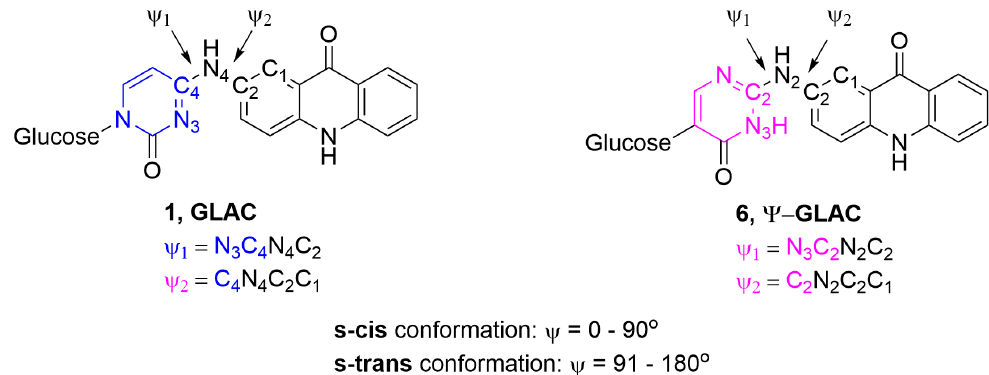
Figure 4. Definition of dihedral angles ψ 1 and ψ 2 and conformations in GLAC and Ψ -GLAC. Computational Studies